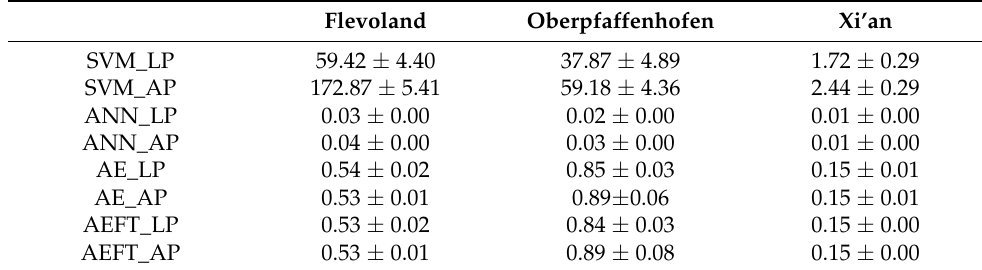
Table 20. Prediction time of four classifier for parameter representative learning on three PolSAR